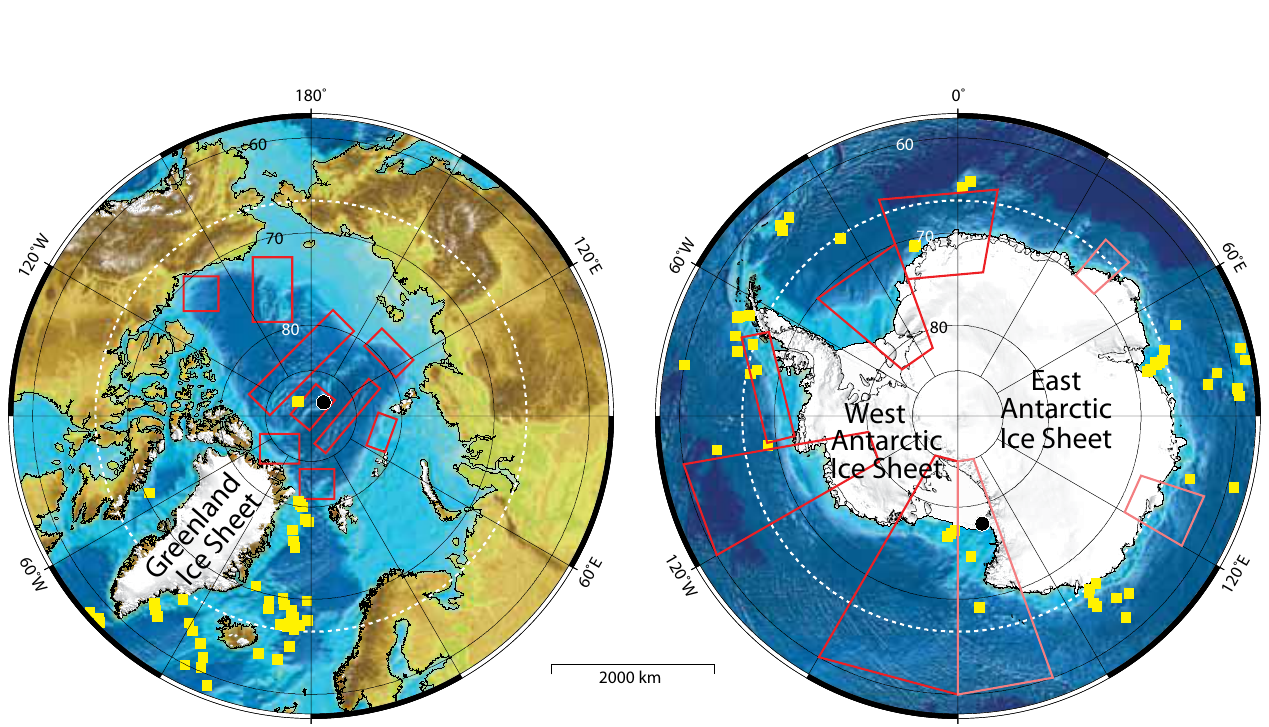
figure 7.1. The arctic (left) and antarctic (right) regions displayed in polar stereographic projection. yellow squares are previous scientific ocean drilling sites, and red open boxes are key areas for future drilling based on invesT white papers. The black dot in the central arctic ocean (left) is the location of the one iodp acex drilling site, and the black dot near the edge of the ross ice shelf (right) is the first andrill project site,